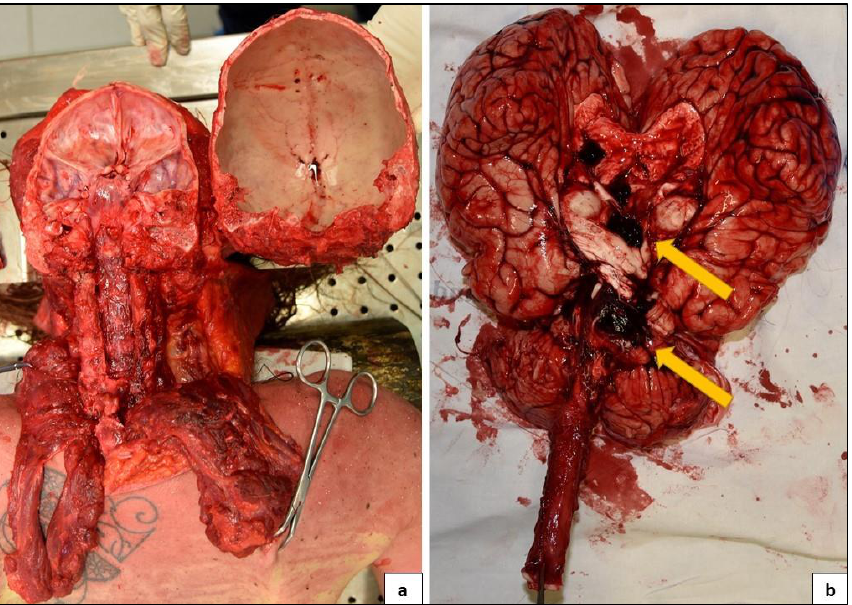
Figure 4. Result of removal of the brain, cerebellum, with the posterior access. Preserved integrity of the vascular structures ( a ). Arrows reveal the site of the hemorrhage ( b ).